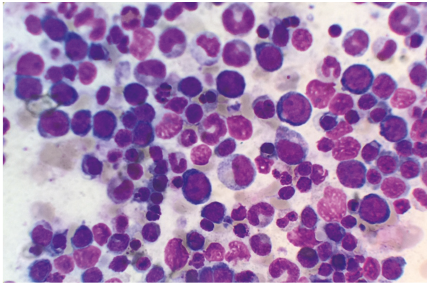
Figure 6: Bone marrow smear showing erythroid hyperplasia with dysplastic features and megaloblastic changes.